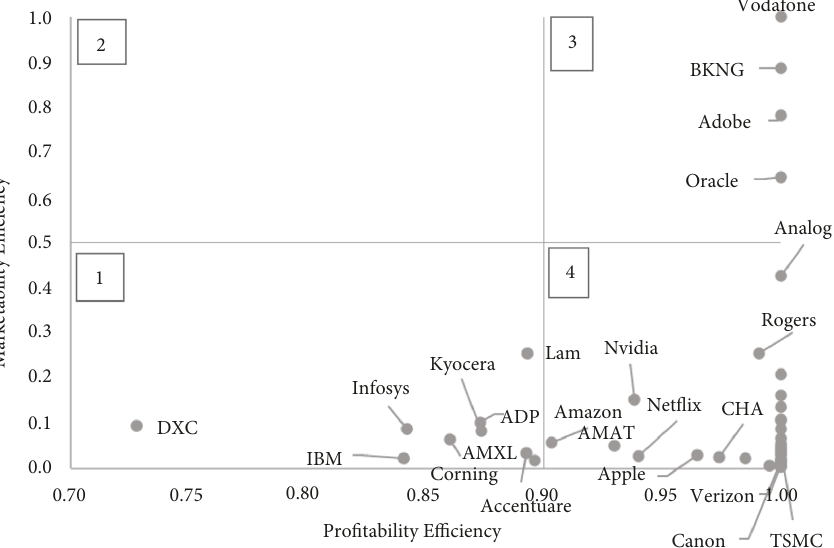
Figure 7: Quadrant of firm